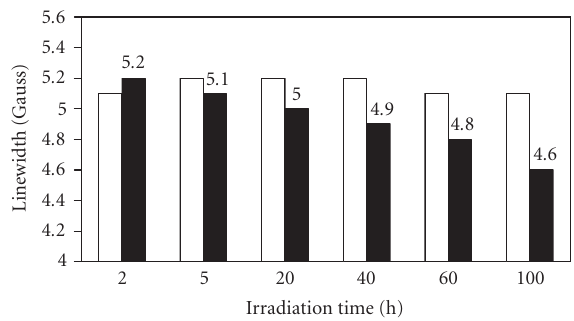
Figure 2: Variation of the linewidth of the free radical versus sun- light irradiation time for Arabian petroleum. Filled columns repre- sent the irradiated samples and blank columns represent the nonir- radiated samples.